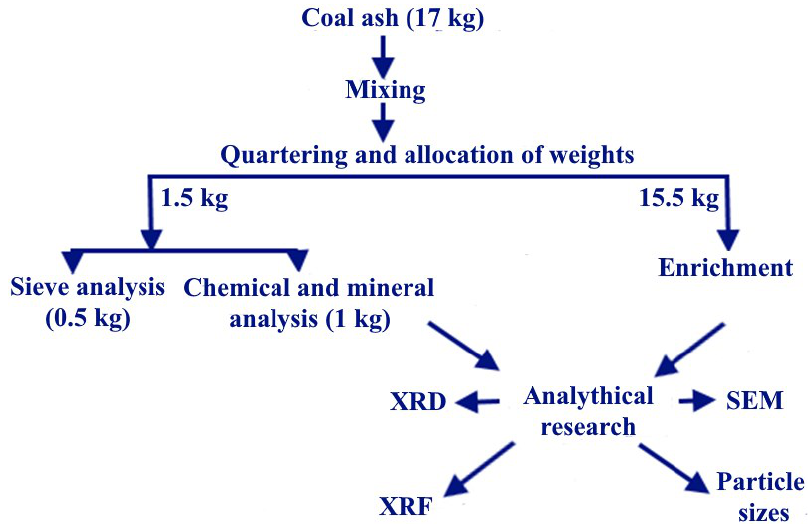
Figure 6. Details on ash sampling.